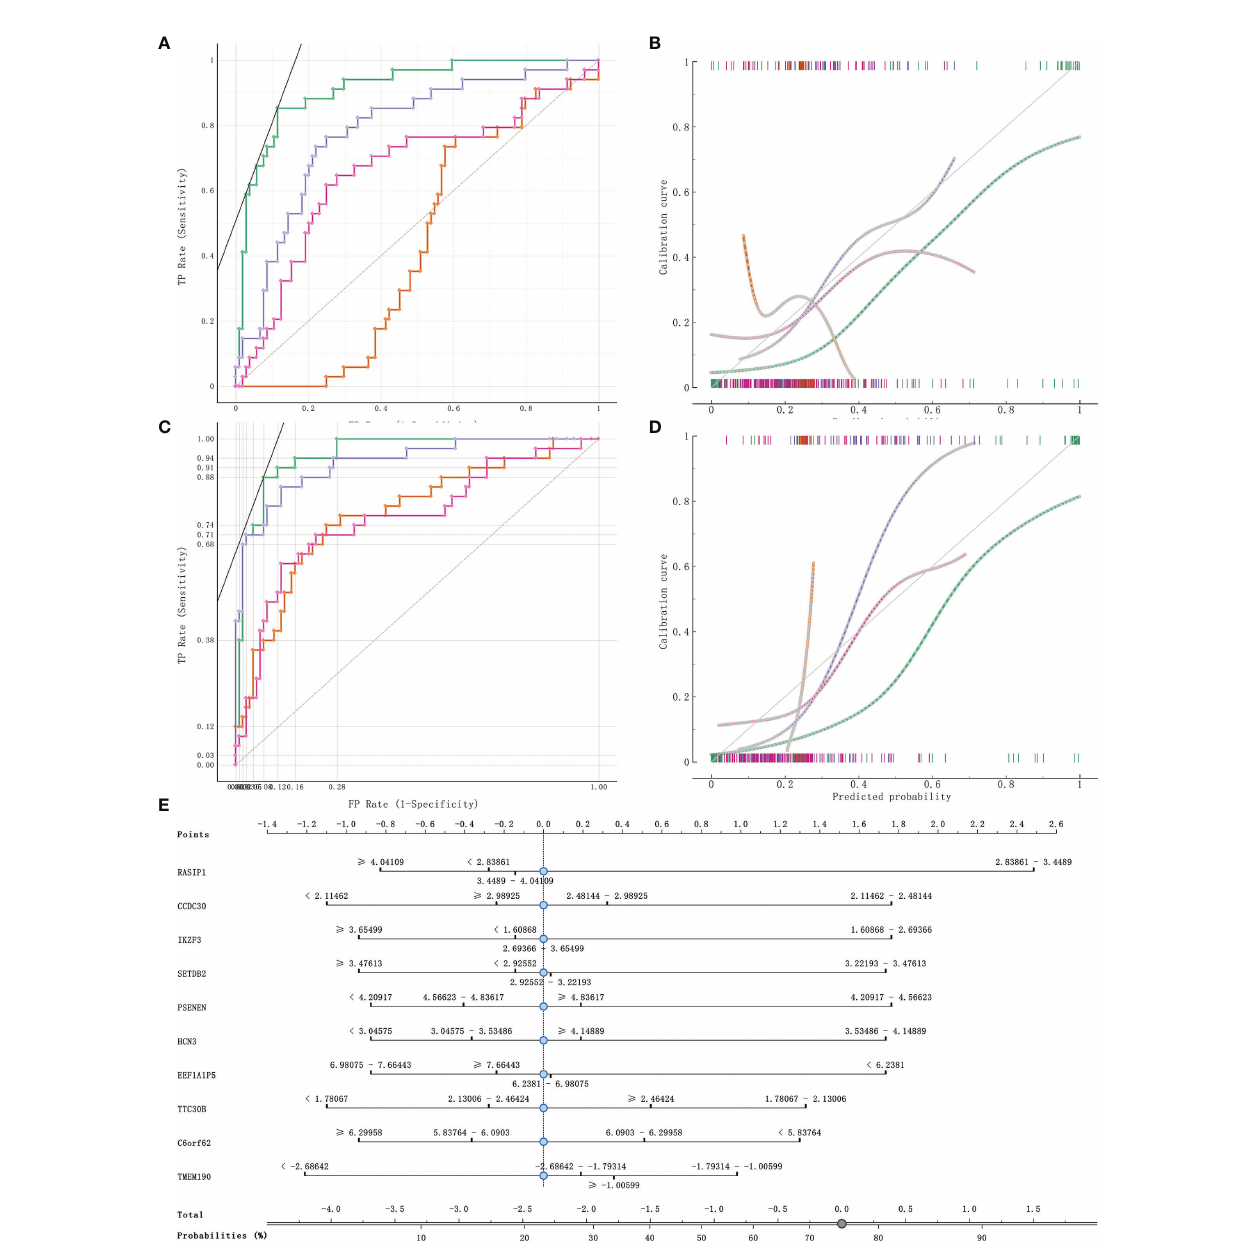
FIGURE 6 | Model evaluation and model validation of classi fi cation models. (A, B) training dataset (TCGA PAAD sample set) used to evaluate AUC and model correction curves for 4 classi fi ers. (C, D) testing dataset (GSE79668) used to evaluate AUC and model correction curves for 4 classi fi ers. (E) The nomogram plot of the naïve Bayesian model. Green refers to Naïve Bayes, orange to SVM, cyan blue to RandomForest and rose to logistic regression.